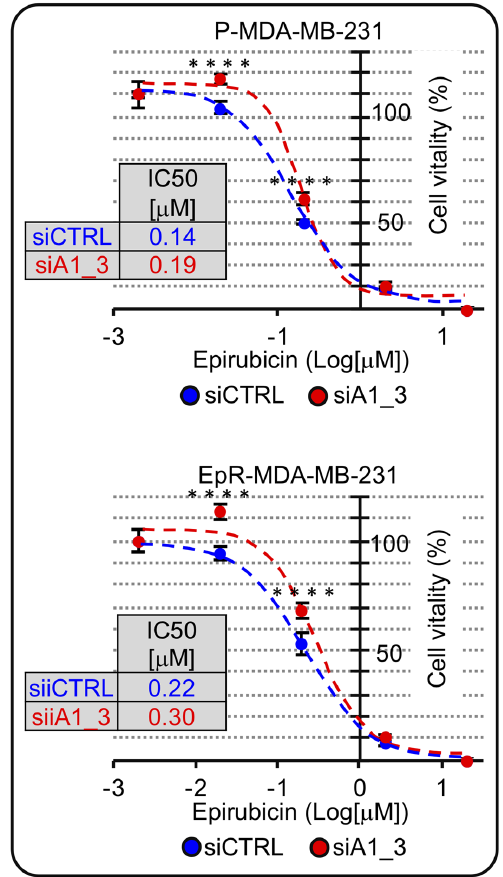
Figure 9. HMGA1 is a chemosensitizer factor for epirubicin-induced cytotoxicity in EpR-MDA-MB-231. MTS-assay in P-MDA-MB-231 and ER-MDA-MB-231 in HMGA1 depleted condition (siA1_3) in comparison with control condition (siCTRL) both treated with different concentration of epirubicin for 48 hrs, to define IC50 value for both cell lines in the two experimental conditions. The Sidak’s multiple comparisons test was used to define statistical significance for dose-response curve (**** = p _value < 0.00005).